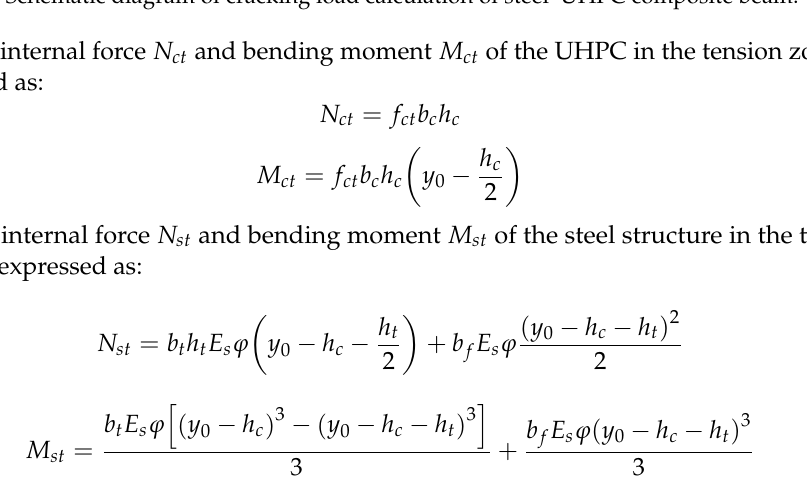
Figure 21. Schematic diagram of cracking load calculation of steel–UHPC composite